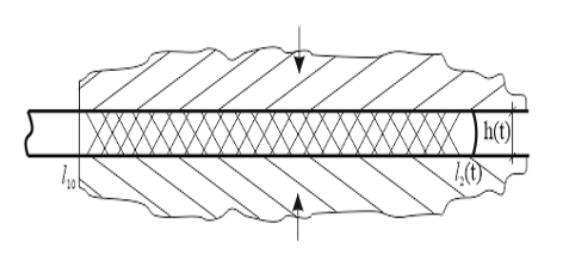
Fig.3. Plastic spreading of the strip with movable